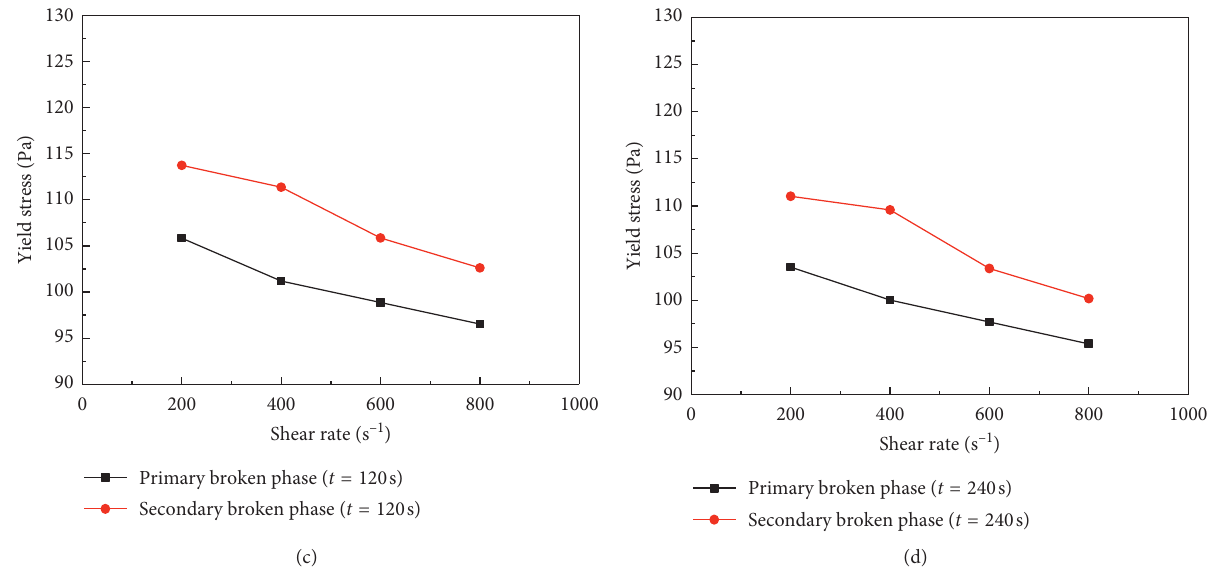
Figure 4: The variation of yield stress with shear rate during different shear times in the primary broken and secondary broken phases.